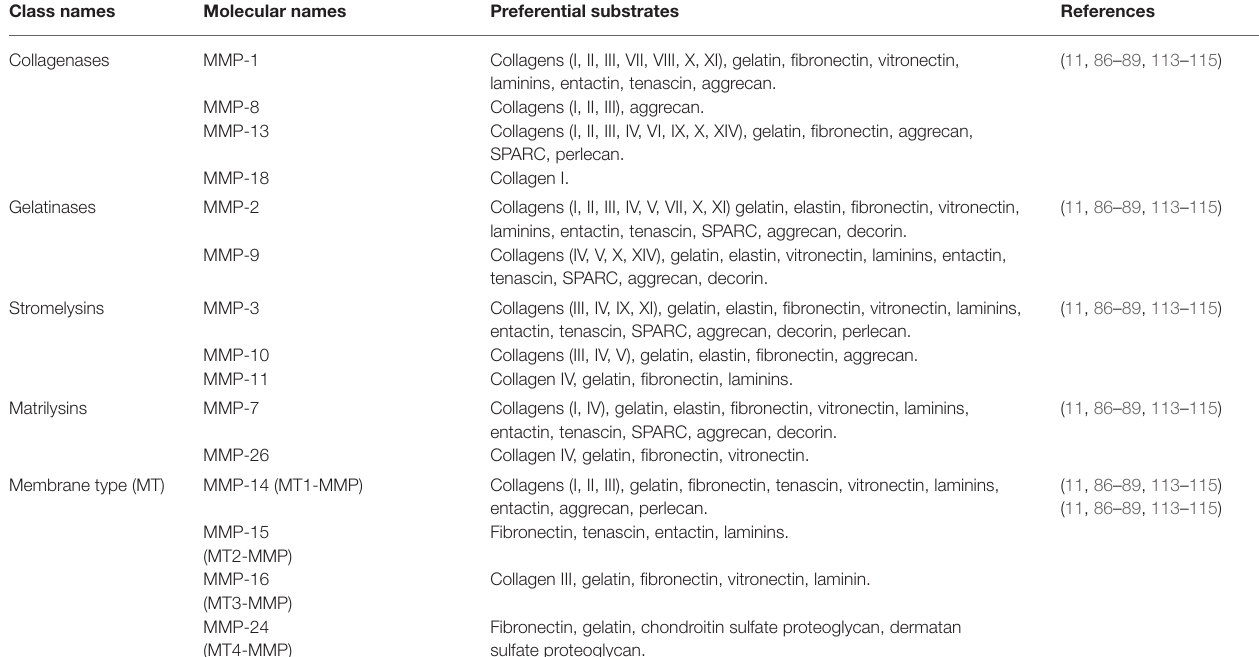
TABLE 5 | Classification of MMPs ECM degrading enzymes and their main